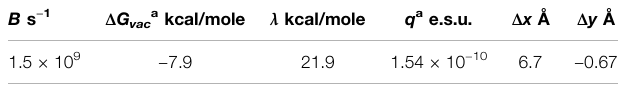
TABLE 4 | TICT parameters of the RFP